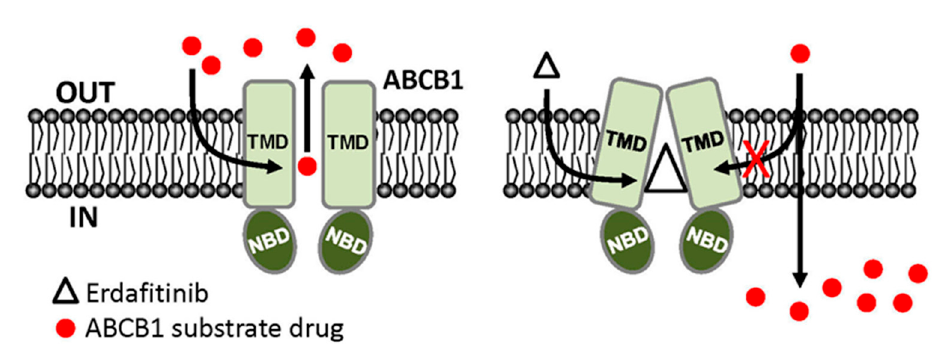
Figure 7. Simplified schematic diagram of erdafitinib modulating the drug efflux function of ABCB1 in multidrug-resistant cancer cells. In the absence of erdafitinib (white triangle), ABCB1 substrate chemotherapy drugs (red circles) are effluxed out of multidrug-resistant cancer cells by ABCB1, reducing the efficacy of these drugs. In contrast, binding of erdafitinib to the drug-binding pocket of ABCB1 outcompetes the binding of ABCB1 substrate chemotherapy drugs to the same site, consequently increasing the intracellular accumulation and efficacy of these drugs in ABCB1-overexpressing multidrug-resistant cancer cells.